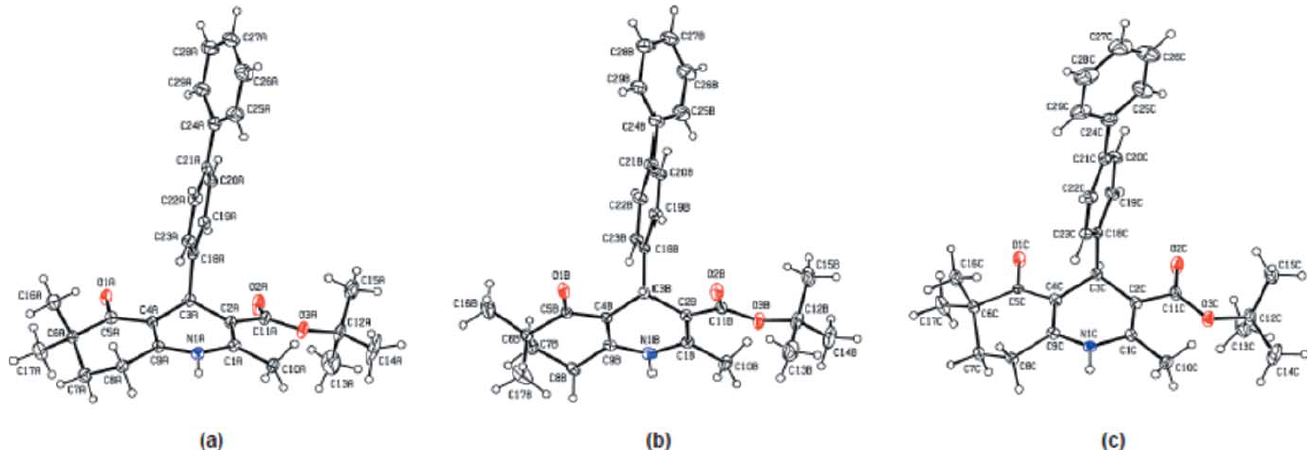
Figure 1 Views from the same direction of the three molecules in the asymmetric unit of the title compound, with displacement ellipsoids for the non-hydrogen atoms drawn at the 30% probability level. ( a ) Molecule A , ( b ) molecule B , and ( c ) molecule C (only the major component of the disorder is shown).